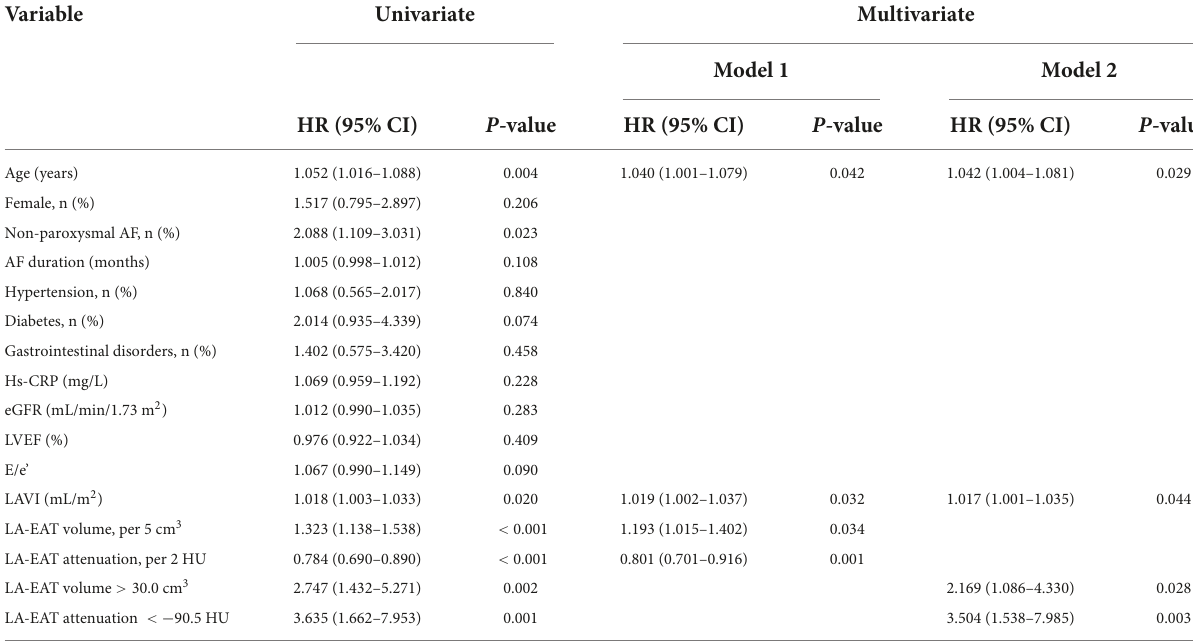
TABLE 5 Association of patient characteristics with LVZ: univariate and multivariate regression analysis. Variable